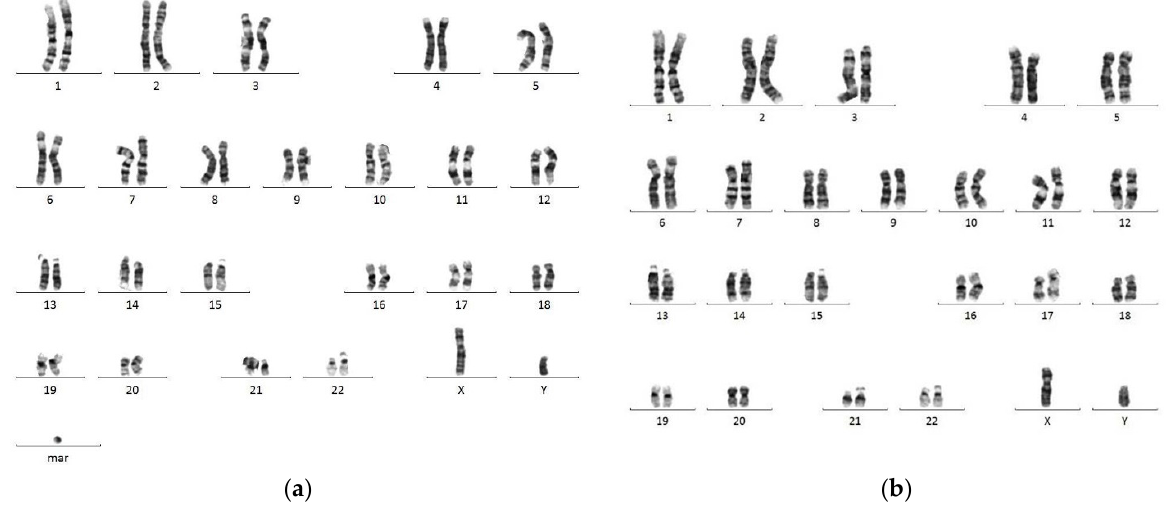
Figure 1. Conventional G-banding analysis of cultured amniocytes at 19 weeks of gestation revealed mosaicism of a supernumerary marker chromosome (sSMC) (47,XY,+mar.[4]/46,XY[16]): ( a ) abnormal male karyotype of 47,XY,+mar; ( b ) normal male karyotype of 46,XY. mar, sSMC.